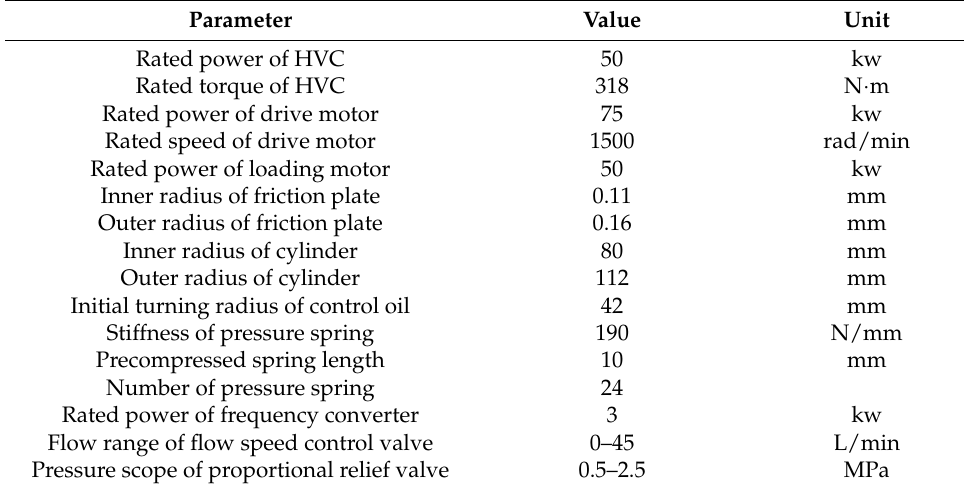
Table 2. Main parameters of the test